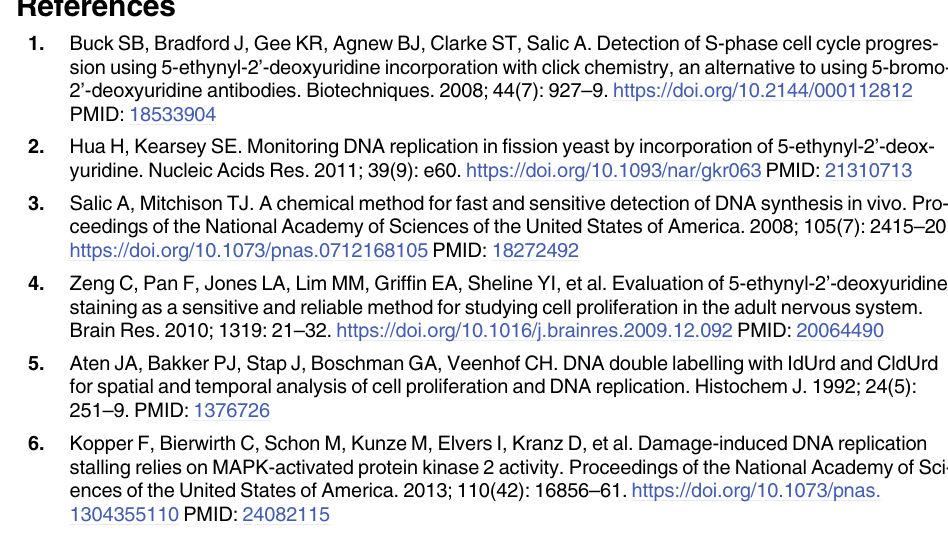
S1 Fig. Comparison of the R/non-R ratio using various methods of BrdU detection. HeLa cells were incubated with BrdU for 30 minutes and fixed with formaldehyde. BrdU was revealed using 20 mM HCl and exonuclease III or 2N HCl or 4N HCl or monovalent copper ions or DNase I (20U/ml). The incorporated BrdU was detected by anti-BrdU antibody clone Bu20a. The data are presented as the mean ± SD. S2 Fig. The effect of the optimized procedure on the localisation of cellular proteins. HeLa cells were incubated with BrdU for 30 minutes and fixed with formaldehyde. BrdU was revealed by 20 mM HCl and exonuclease III treatment. The proteins NTH1, RPA32, PRAF1, MCM7 and PCNA were concurrently detected with the incorporated BrdU. The control cells were not labelled with BrdU and were not treated with HCl and exonuclease III. Proteins are in green, BrdU is in red and DAPI is in blue. Scale bar = 20 μm. S3 Fig. Comparison of DNA content in control and HCl-treated cells. HeLa cells were incu- bated with BrdU for 30 minutes and fixed with formaldehyde. BrdU was revealed using 40 mM HCl and exonuclease III. The control cells were not labelled with BrdU and were not treated with HCl and exonuclease